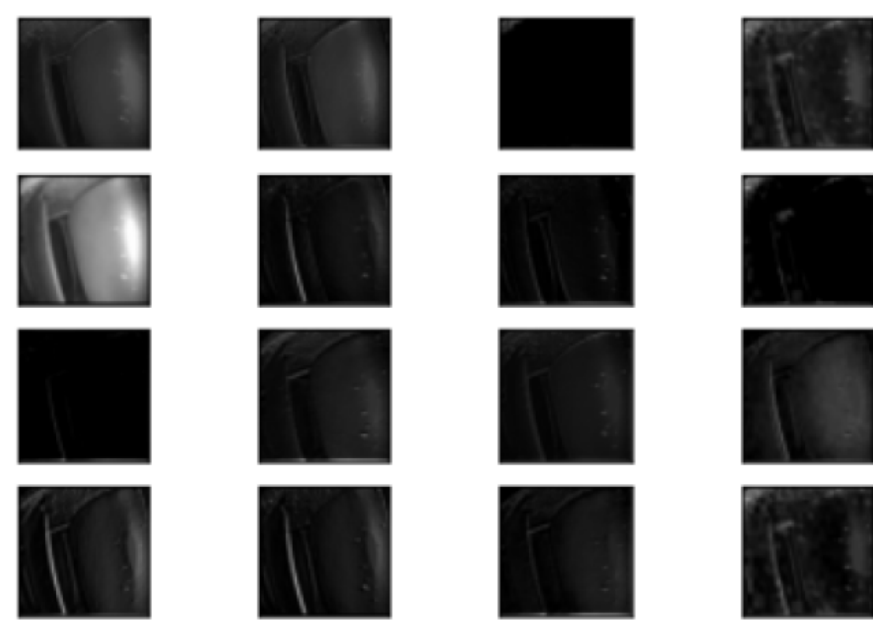
Figure A14. Feature extractor model structure for transfer learning.